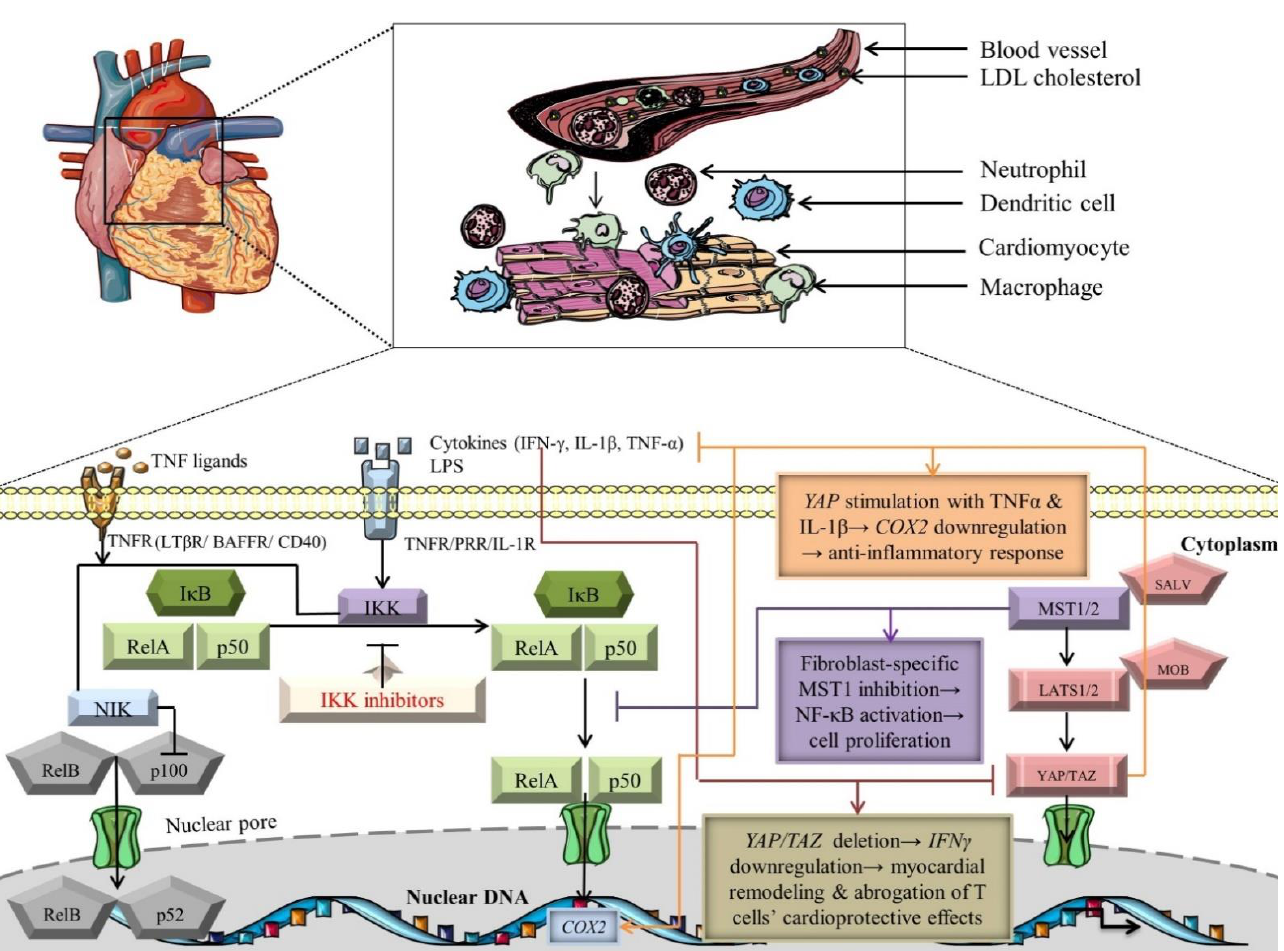
Figure 2. Crosstalk-dependent outcomes of NF-κB and Hippo signaling pathways. The black arrows designate central signaling pathways; the continuous lines denote induction; and the continuous blunt-ended lines signify inhibition. BAFFR: B cell-activating factor receptor; COX2: cyclooxygenase 2; IFN-γ: Interferon γ; IkB: inhibitor of NF-kB; IKK: IκB kinase; LATS1/2: large tumor suppressor 1/2; LPS: lipopolysaccharide; LTβR: lymphotoxin β receptor; MOB: LATS1/2-interacting protein Mps one binder; MST1/2: mammalian Sterile 20-like kinases 1/2; NF-kB: nuclear factor kappa-light-chain-enhancer of activated B cells; NIK: NF-κB-inducing kinase; SALV: Salvador; TAZ: transcriptional co-activator with PDZ-binding motif; TNF-α: tumor necrosis factor α; TNFR: TNF receptor; and YAP: Yes-associated protein. Segments of the figure were portrayed by using